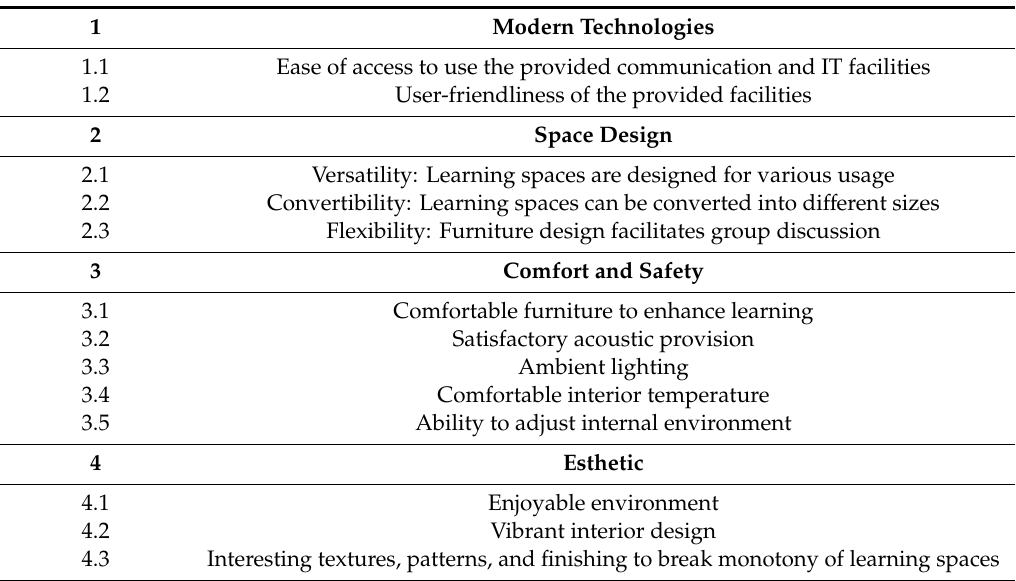
Table 1. Essential design principles of built